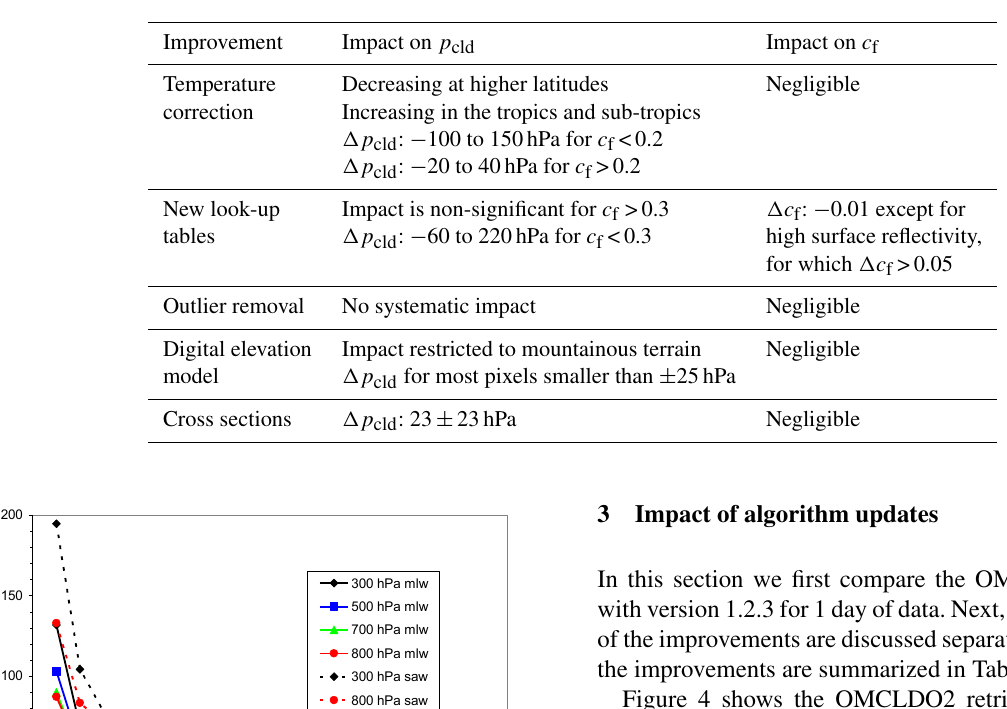
Table 3. Impact of the improvements of the effective cloud fraction and effective cloud pressure retrievals.